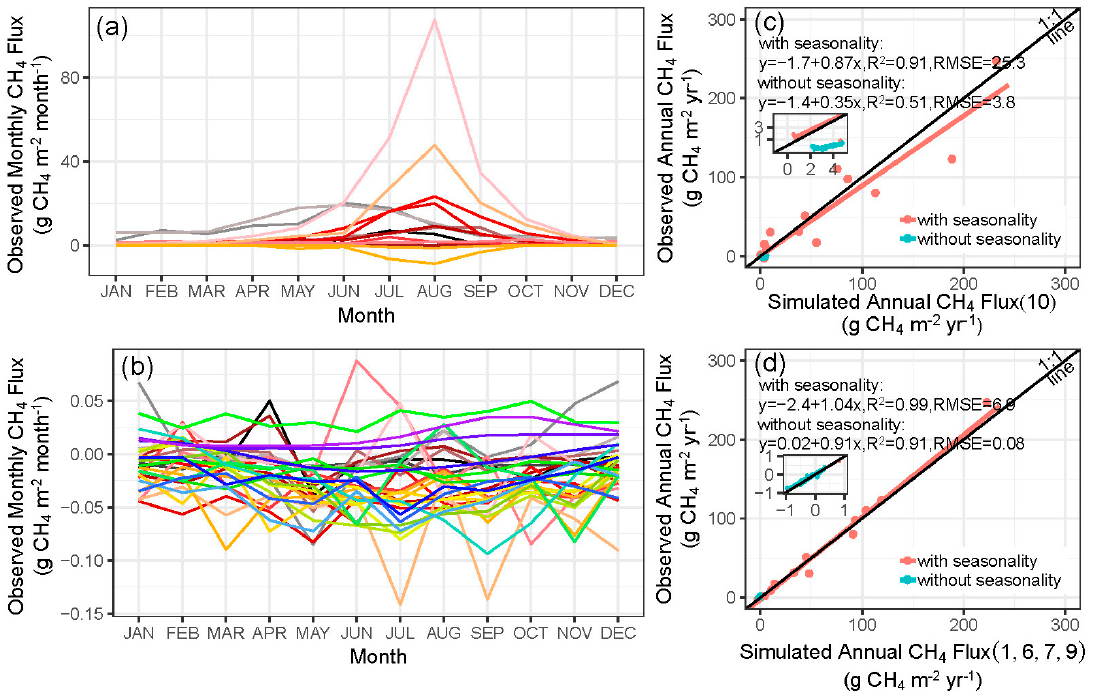
Figure 10. Agreement between simulated and observed annual CH 4 flux of data with or without a seasonal pattern. ( a , b ) are monthly variation of flux with and without a seasonality, respectively. The flux with one peak across a year was categorized as the with-seasonality group, whereas the flux presenting several peaks or no obvious peak across a year was categorized as the without-seasonality. ( c , d ) are simulation verification of flux with or without seasonality, using one and four monthly fluxes, respectively. The simulated fluxes in ( c , d ) were derived using Equations (B5) and (B8) in Table 3, respectively. The small plots on the left of ( c , d ) are the enlarged portions of the small fluxes.